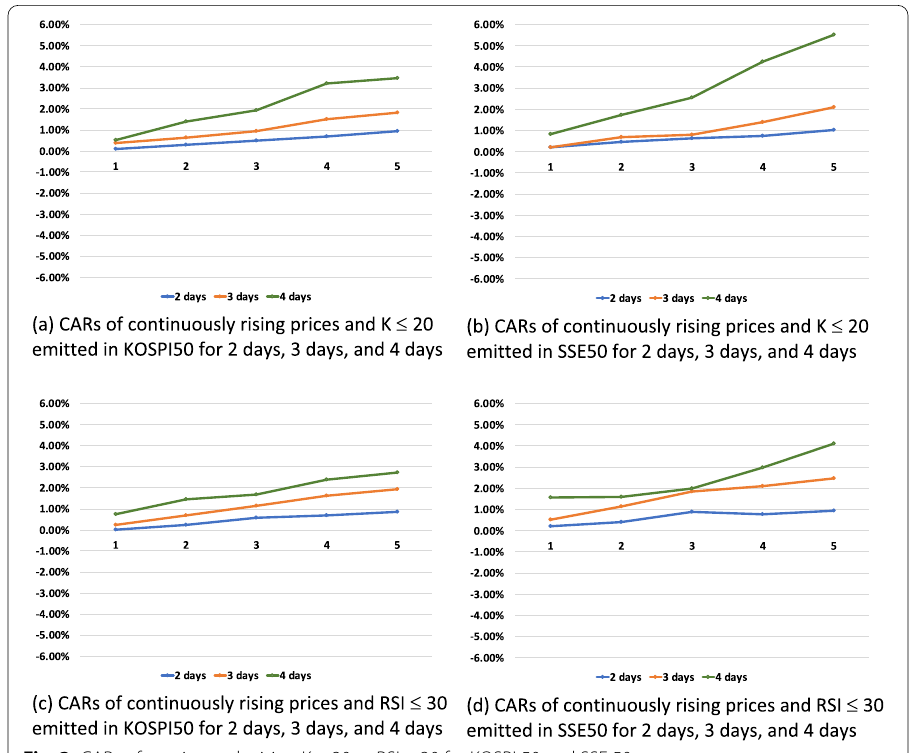
Fig. 3 CARs of continuously rising K